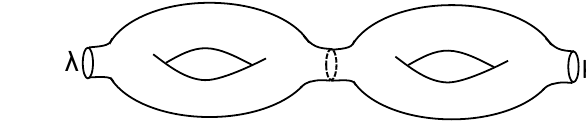
Figure 2. ( a ): the composition (cid:17) (cid:14) ( (cid:3) (cid:10) id) = (cid:17) (cid:14) (id (cid:10) (cid:3) ) : V (cid:10) 3 an in-boundary of an annulus and an out-boundary of a pant which is equivalent to a sphere with three in-boundaries. ( b ): the associativity condition for V (cid:10) 3 two di(cid:11)erent gluing of two pants.